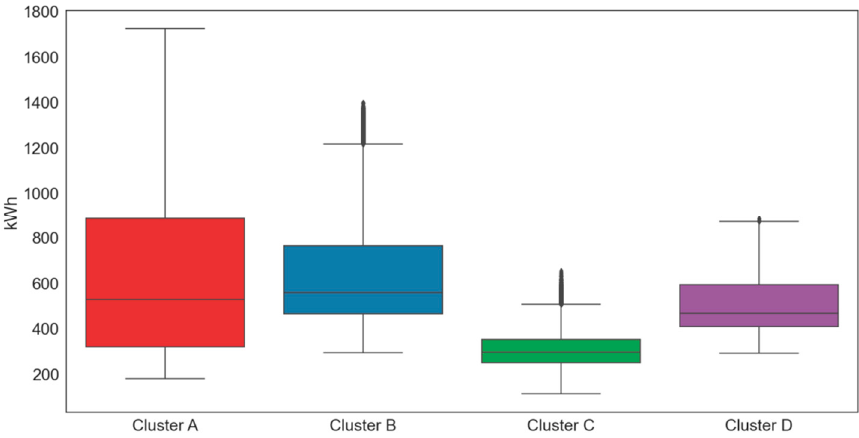
Figure 8. Boxplots by cluster (kWh).